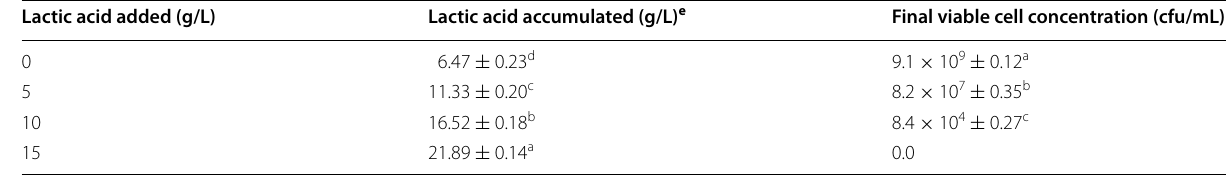
The results presented are the average of triplicate experiments and are expressed as mean a,b,c,d Mean values in the same row with different superscripts are significantly different from each other (P < 0.05) e Lactic acid accumulated is the total of lactic acid added to the culture and lactic acid produced from fermentation